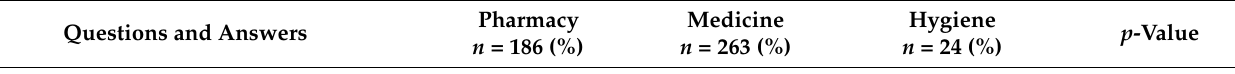
Table 6. Perceptions regarding vaccination